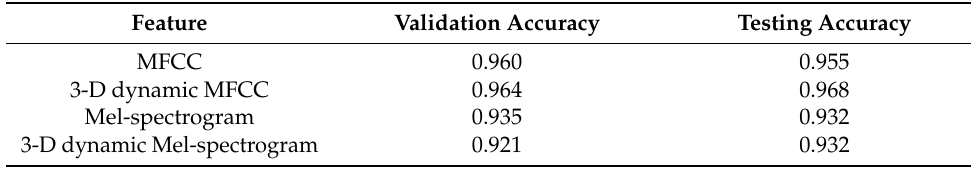
Table 4. The accuracy of the proposed model under different features.